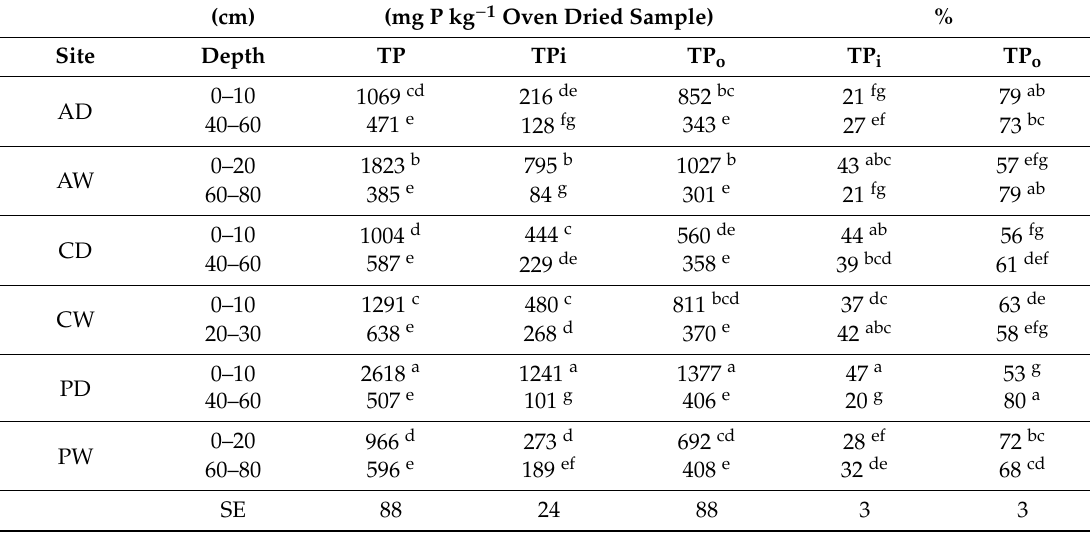
Table 2. Phosphorus fractions determined by the ignition